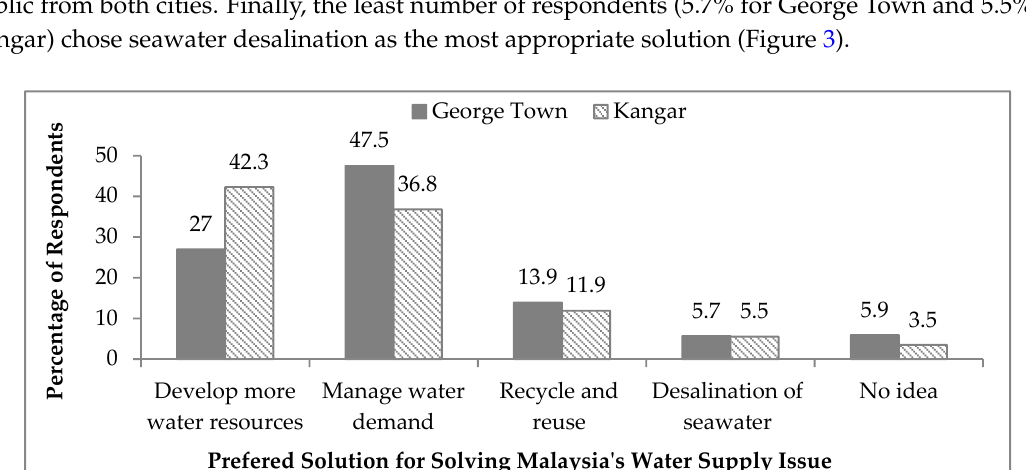
Figure 4. Self ‐ responsibility towards water loss issue.